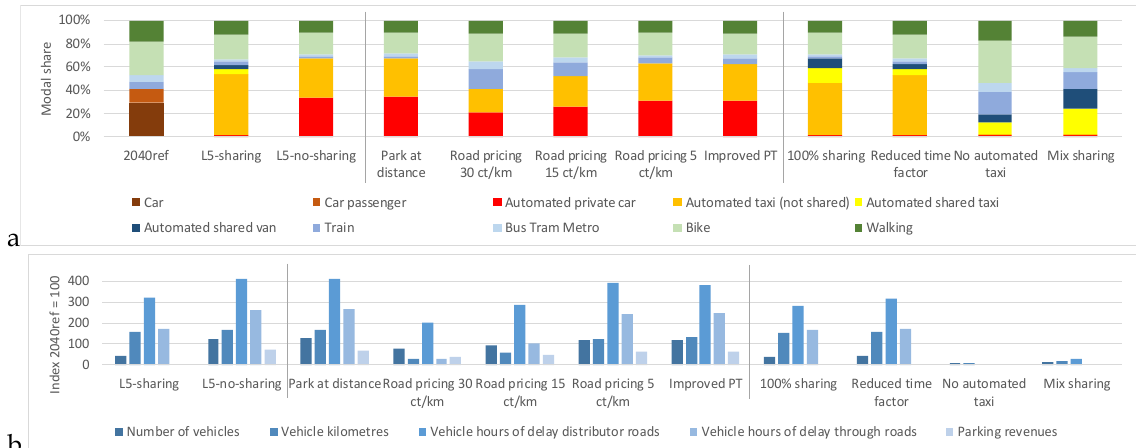
Figure 6. Modal split effects (a) and traffic effects and parking revenues (b)